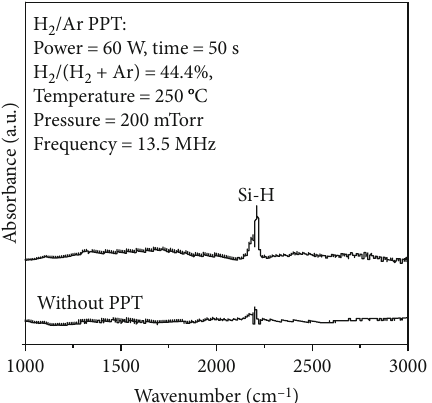
Figure 6: FTIR spectra of silicon substrate with and without H PPT samples at wavenumbers ranging from 1000 to 3500cm -1 .